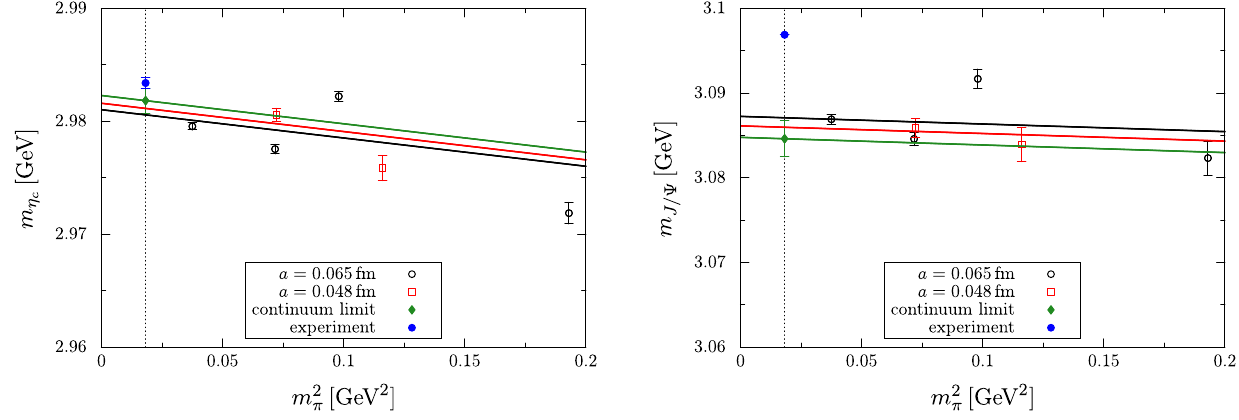
Fig. 5 Extrapolation at the physical point of m η